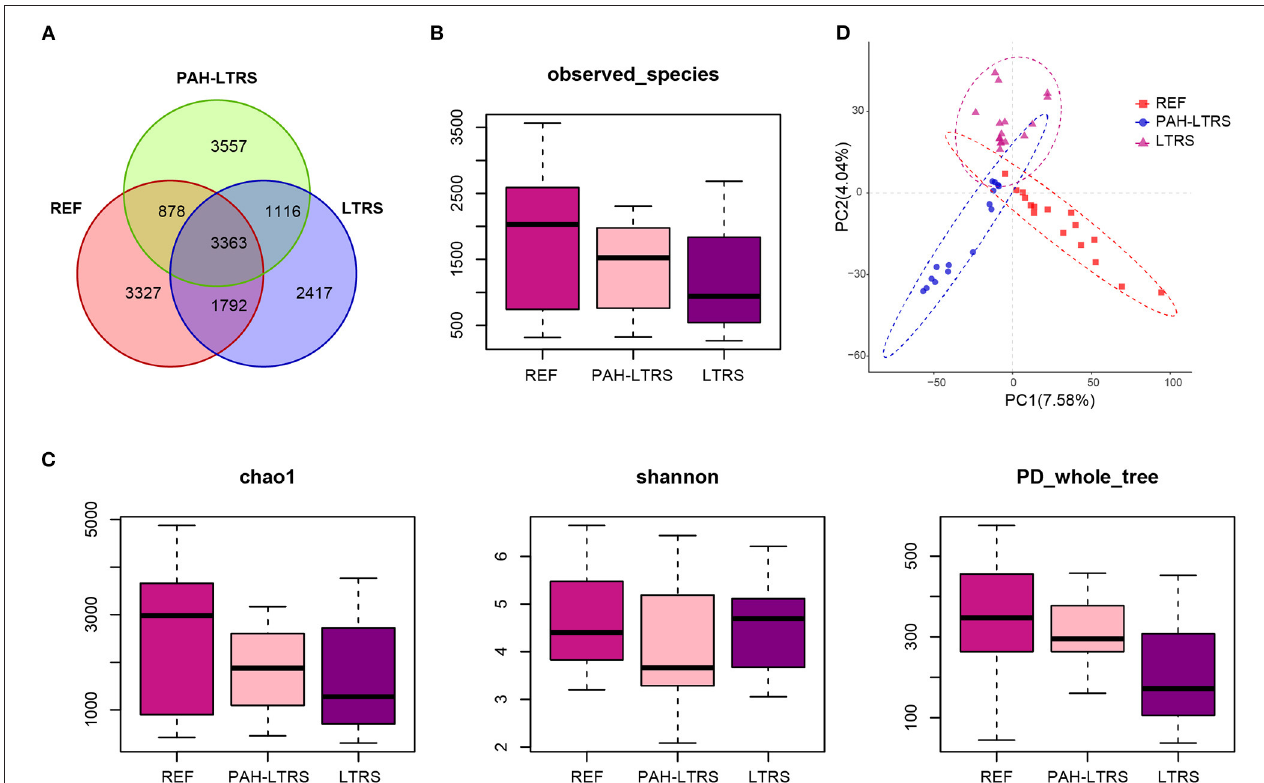
FIGURE 1 | Pulmonary bacterial community diversity in different cohorts and Principal Coordinate Analysis (PCoA) clustering. (A) Venn diagram of OUTs detected in three cohorts. (B) The number of species identified in three groups. (C) α -diversity among three cohorts measured by the Chao, Shannon and PD whole tree. Results were present as means ± s.e.m. (D) PLS-DA was conducted to compare the overall similarities in the bacterial taxonomy based on β -diversity. Each principal component represents most of the variation between samples. PAH-LTRS, patients with pulmonary arterial hypertension associated with Left-to-Right shunt ( n = 15); REF, healthy reference ( n = 16); LTRS, patients with Left-to-Right shunts but without PAH ( n =